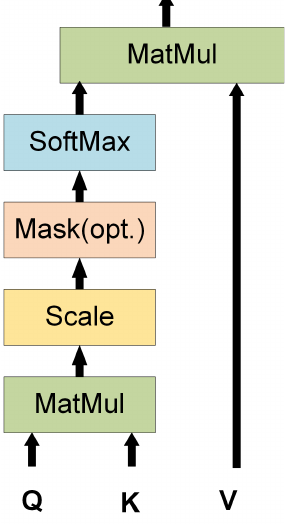
Figure 3. Scaled Dot-Product